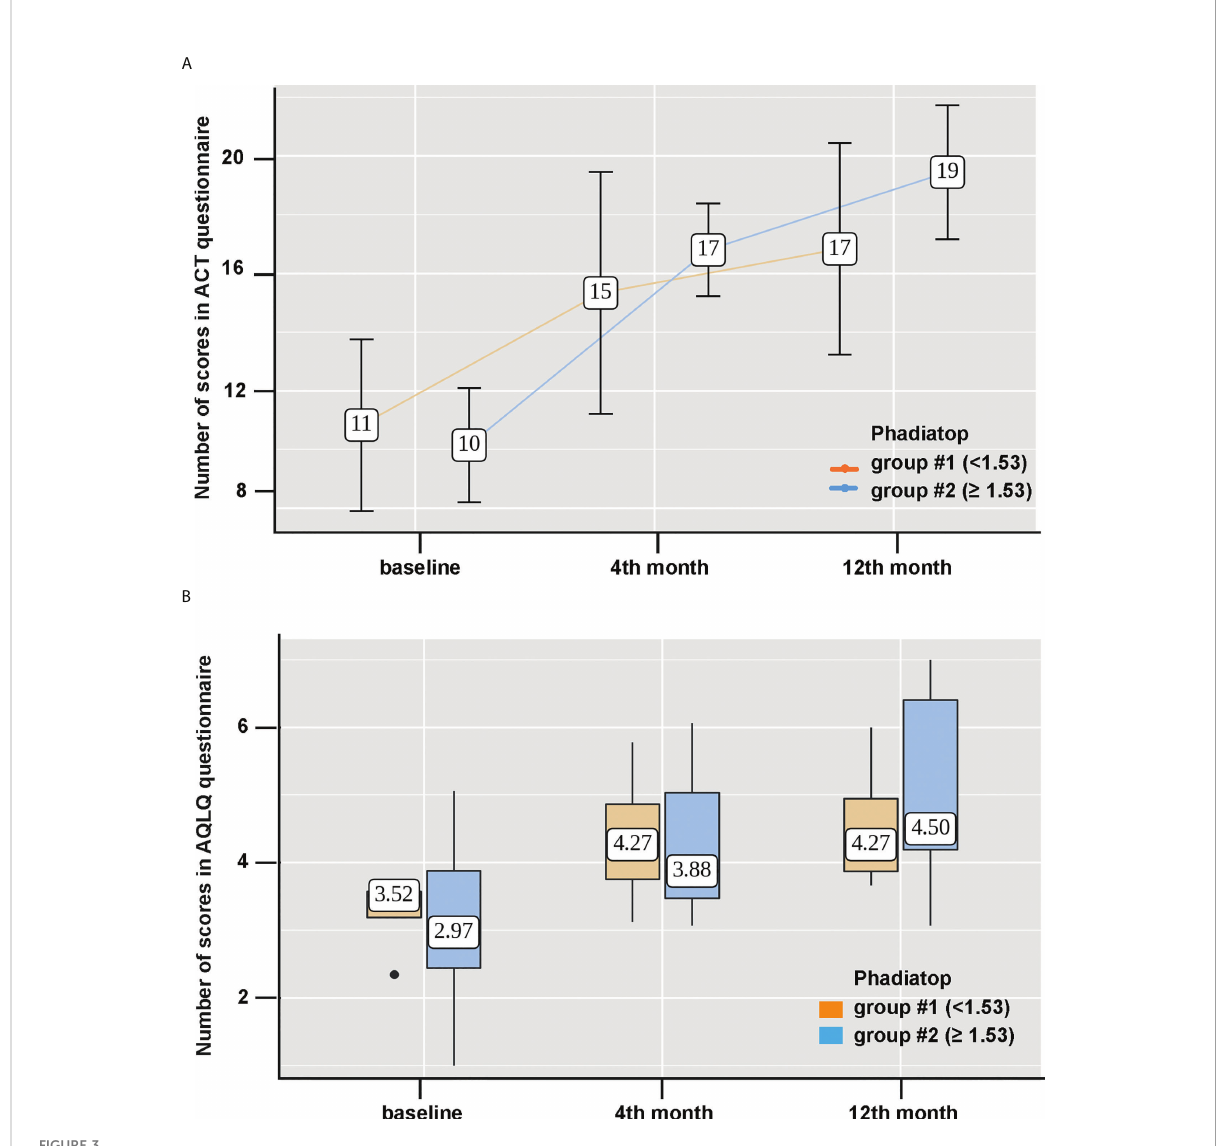
FIGURE 3 Improvement of asthma control level and the quality of life after Omalizumab treatment. (A) Changes of asthma control levels according to ACT questionnaire scores (points) and (B) dynamics of the quality of life according to AQLQ questionnaire scores (points) during Omalizumab therapy based on the initial value of the Phadiatop ™ test (y-axes). Group 1, < 1.53 PAU/l (light brown, left) and group 2, > 1.53 PAU/l (blue, right) were compared. #stands for number in Figure